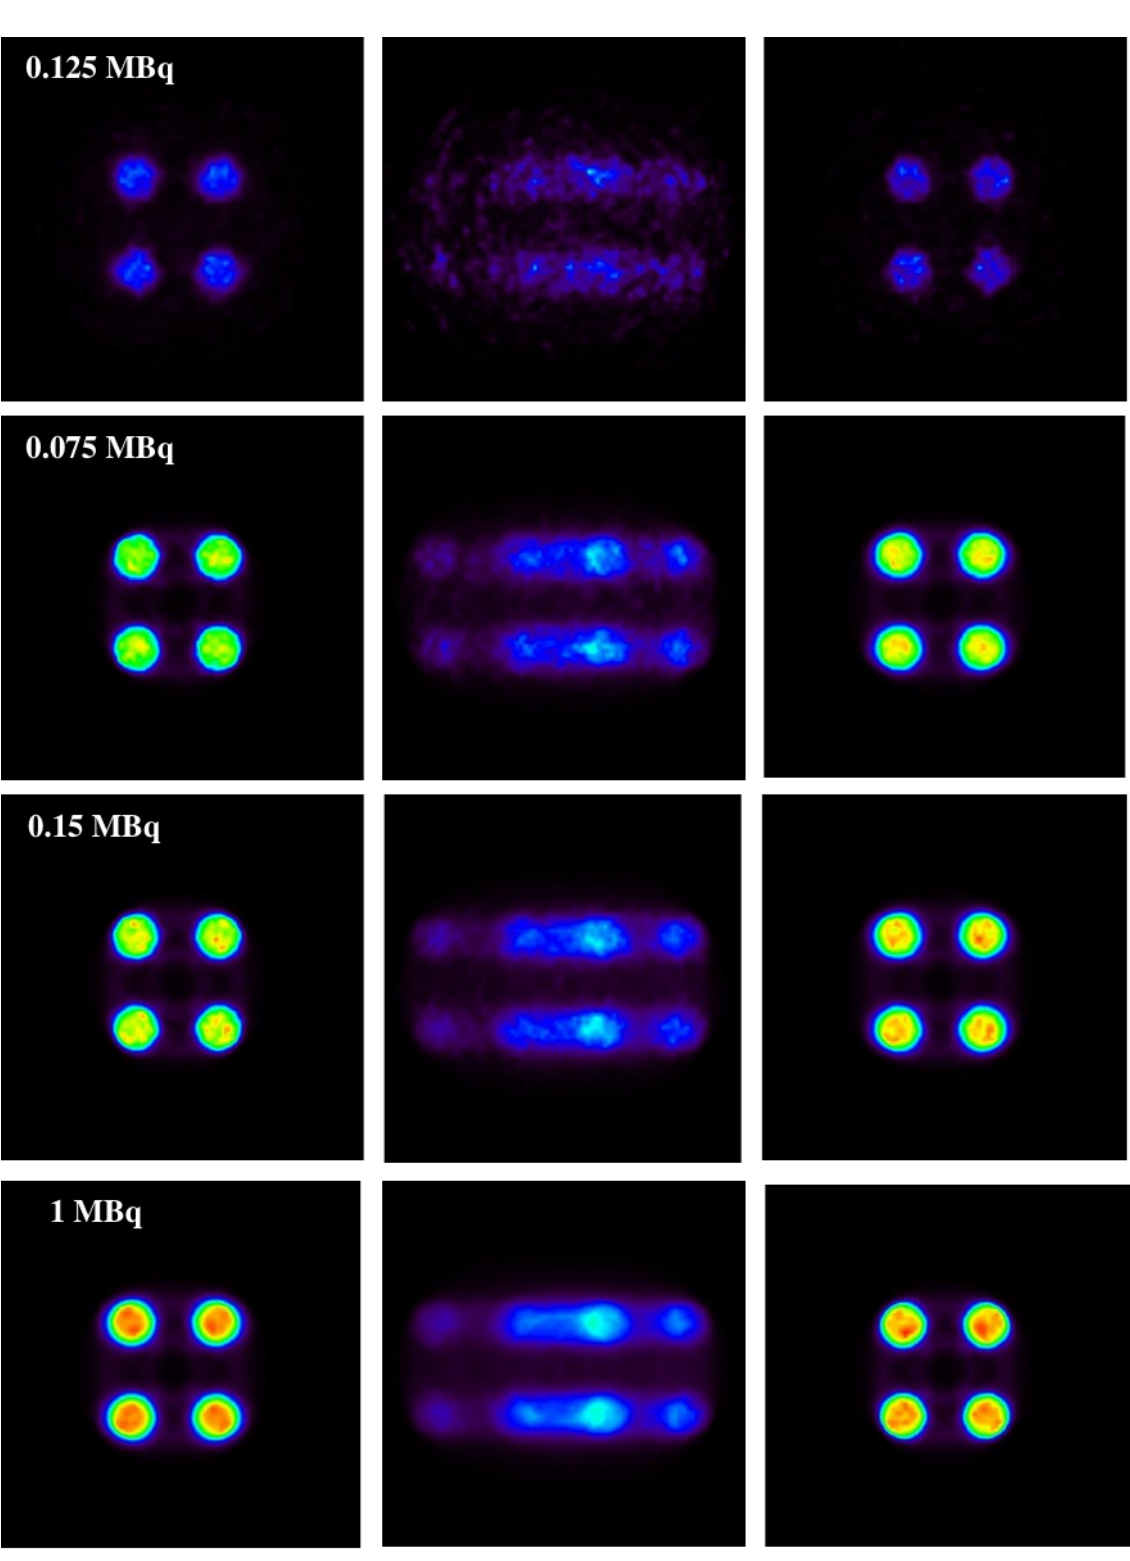
Figure 6. Cylindrical phantom reconstructed for different activities. From ( left ) to ( right ), static image (ground truth), uncorrected (motion-affected) image, and motion-corrected image. It is shown that the corrected image correctly preserves the activity of the original